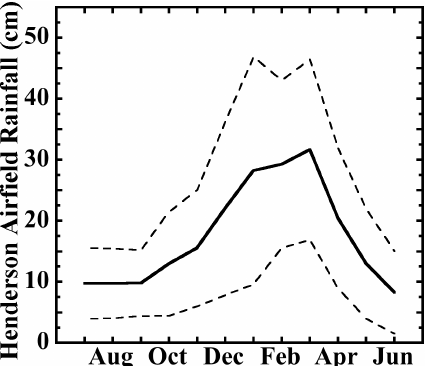
Figure 2. Seasonality of rainfall on northern Guadalcanal. Rain gauge climatology from Henderson Airfield on the northern coast of Guadalcanal (1951–1989), 10km northeast of Forestry Cave. Dashed lines indicate ± 1 σ for each climatological month. Rain- fall amount over the study site does exhibit strong seasonality, with 65% of mean total annual rainfall (TAR, 2.10 ± 0.41m, 1 σ , 1952– 1989) occurring during December through April. Despite this clear seasonality, during the drier season (May through November) rain- fall amounts are still